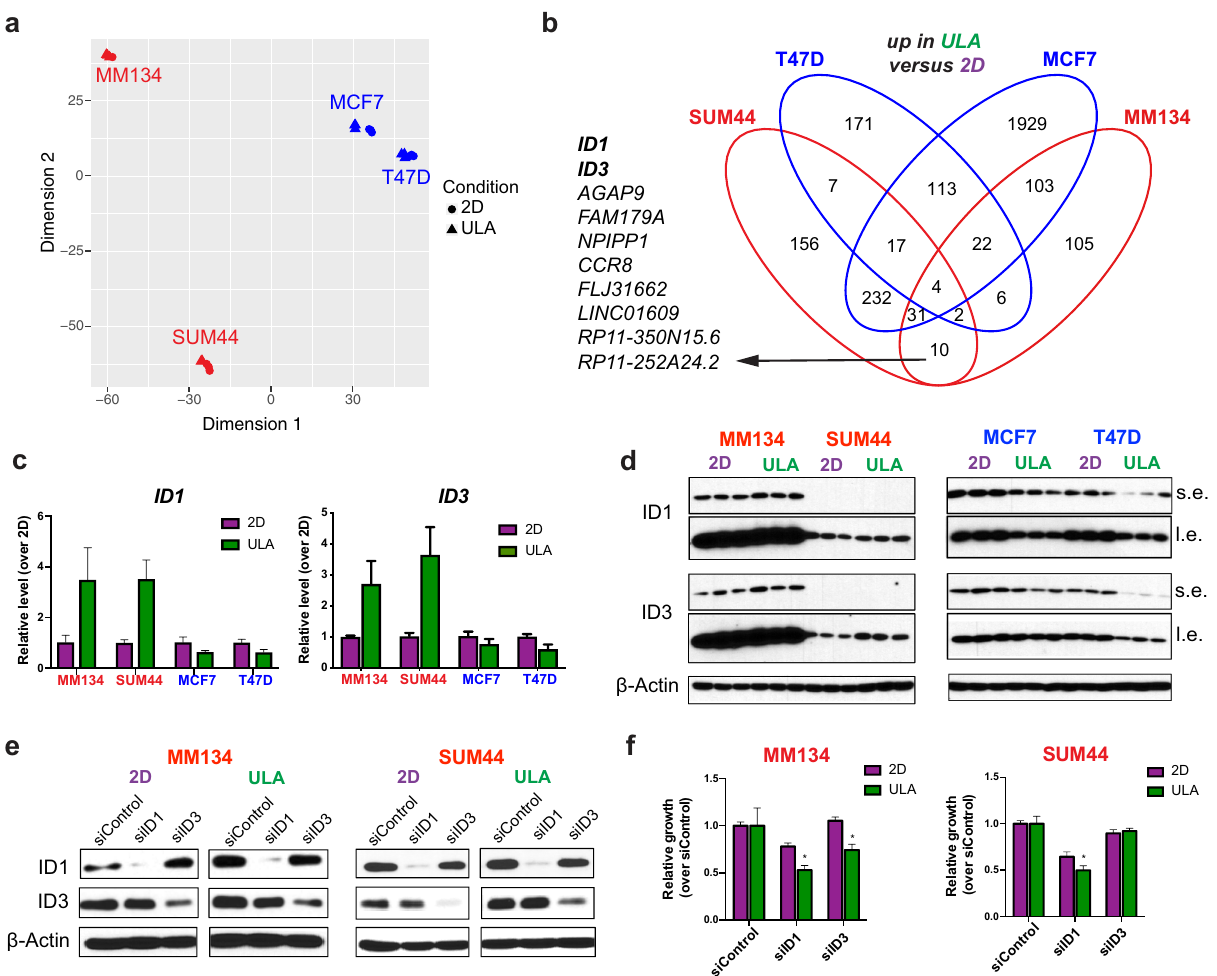
Figure 5. Transcriptomic profiling of ILC and IDC cell lines in 2D and ULA culture and ID1/ID3 upregulation in ILC ULA culture. ( a ) PCA of transcriptomic data from the ILC (red) and IDC (blue) cell lines grown in 2D (circle) or ULA (triangle) culture for 24 h using the top 5,000 most variable genes ranked by interquartile range. ( b ) Venn diagrams showing the overlap between the genes upregulated in ULA (green) culture as compared to 2D (purple) in the cells from ( a ). The list on the left shows the 10 genes commonly upregulated in the two ILC but not the IDC cell lines. ( c , d ) qRT-PCR ( c ) and immunoblotting ( d ) validation of the ID1 and ID3 upregulation in ULA culture in the ILC (left) but not IDC (right) cell lines. Data is displayed as mean ± standard error relative to the 2D condition in each cell line. Graphs show data from three biological replicates. β-Actin was used as a loading control. s.e: short exposure. l.e: long exposure. ( e , f ) ID1 and ID3 immunoblotting ( e ) and growth ( f ) of MM134 (left) and SUM44 (right) cell lines 4 days after transient transfection with the indicated siRNAs. Data is displayed as mean ± standard deviation relative to siControl in each condition in each cell line (n = 6). p-values are from t tests between 2D and ULA for each siRNA. *p ≤